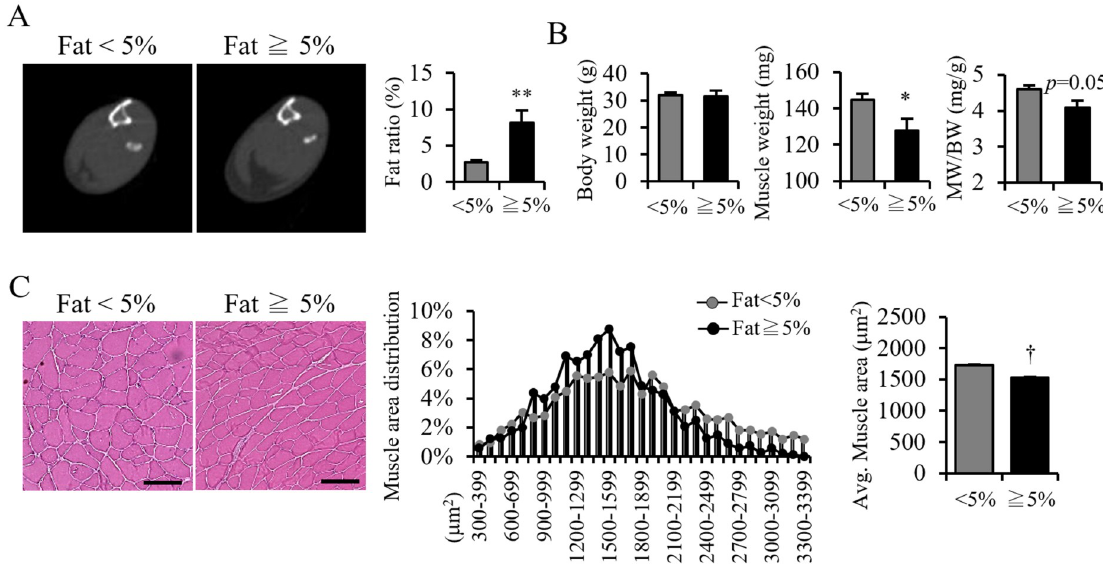
Fig 2. Aged mice exhibit PMAT increases with aggravated sarcopenia. (A) Representative CT images (left panels) and calculated fat ratio in lower limbs (right panel) in aged mice with less than ( < 5%) and equal to or more than 5% ( ≧ 5%) PMAT. (B) Body weight (BW), muscle weight (MW) and MW/BW ratio in aged mice in both groups (n = 6 per group). (C) Representative HE staining in aged mice in both groups (left panels; scale bar 100 μ m) and quantified distribution (middle panel) and average CSA of muscle fibers (right panel) (n = 1200– 1500 per group) in aged mice of both groups. (Scale bar: 100 μ m in C). Data are presented as means ± S.E. Statistical significance was determined by Student’s t-test. � , p < 0.05; �� , p < 0.01; †, p <